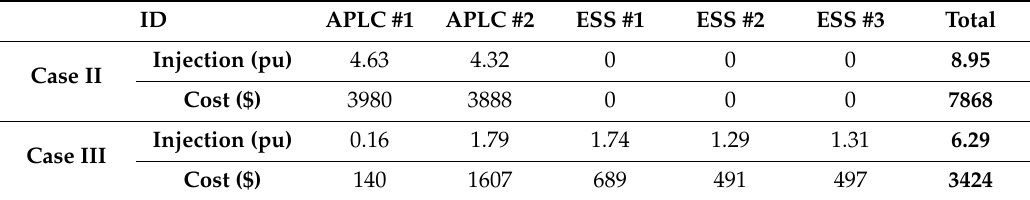
Table 5. Total harmonic compensation injection of AHF in Case II and Case